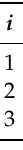
Table 5. Surplus values.